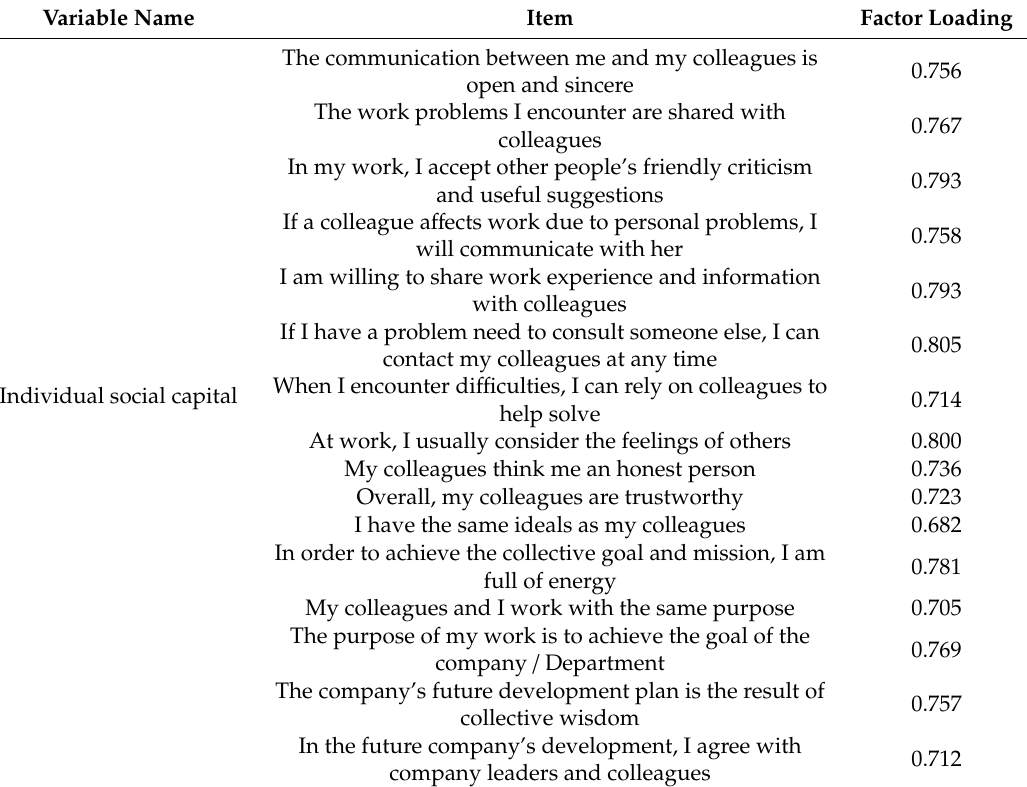
Table 3. Convergence validity test of individual social